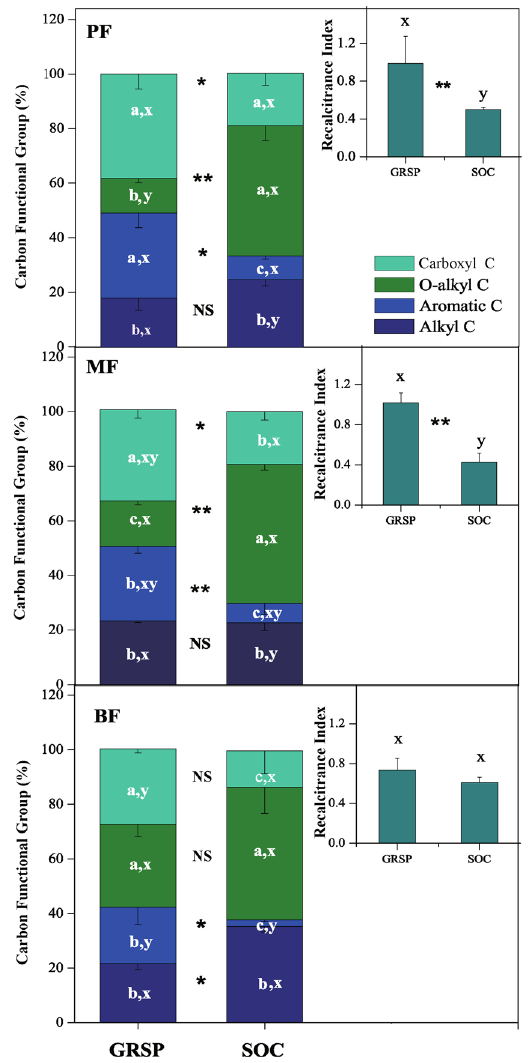
Figure 3. Distributions of functional groups of GRSP and SOC in the three tropical forests in DBR, southern China. Data are presented as means with deviations of 7 replications. The inserted figures present the recalcitrance indexes, indicated by (alkyl C + aromatic C)/(O-alkyl C + carboxyl C), of GRSP and SOC. Different letters indicate significant differences ( P < 0.05) between the C functional groups (a, b, c) and between the forests (x, y, z), and * or ** indicates significant differences in the C functional groups or recalcitrance index between GRSP and SOC at P = 0.05 or P = 0.01 level,